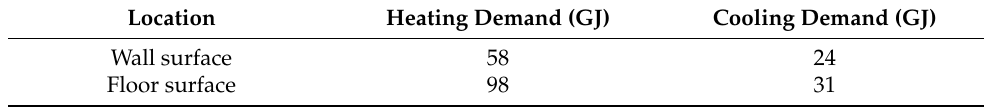
Table 2. The effect of radiant panel location on energy demand in dynamic